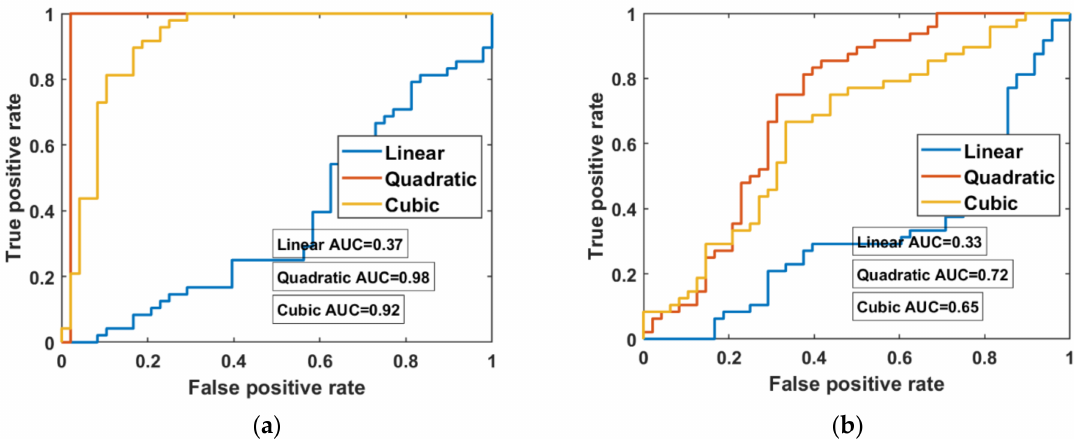
Figure 7. Receiver operating characteristic curves of signals of a dataset with performance of three kernels for an SVM classifier: ( a ) single signal of oxyHb using the quadratic kernel with an area under the curve of 0.998, and ( b ) combination of five signals with the optimal area under the curve of 0.72 with the cubic